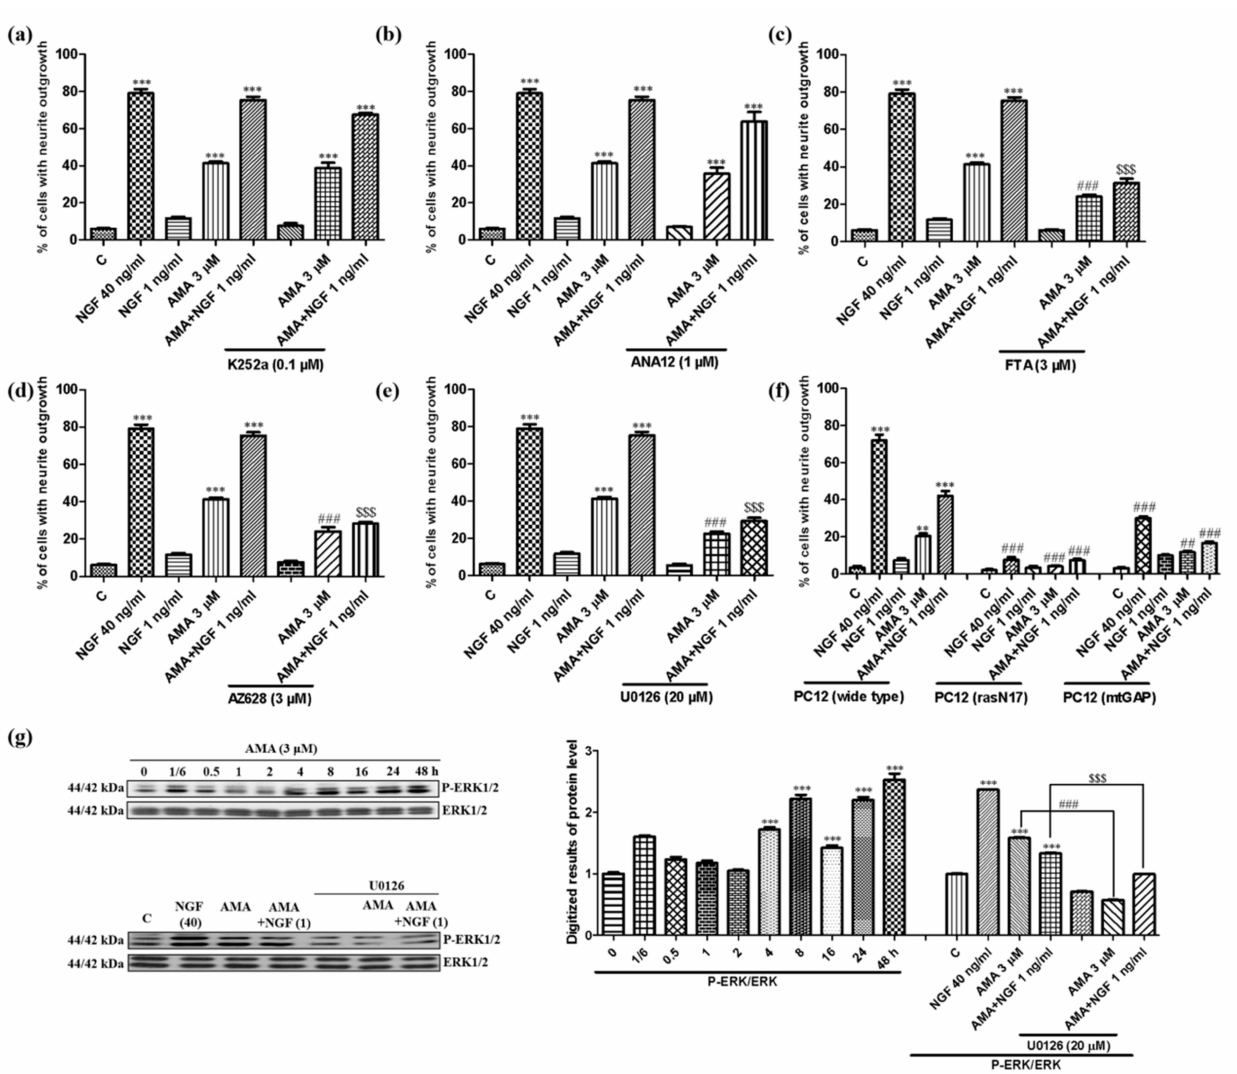
Figure 3. Effect of AMA on the Ras/Raf/MEK/ERK signaling pathway in PC12 cells. ( a , b ) Effect of TrkA inhibitor K252a and TrkB inhibitor ANA-12 on the neurite outgrowth induced by AMA and AMA combined with the NGF. ( c – e ) Effects of Ras, Raf and MEK inhibitors on the neurogenesis activity of AMA and AMA combined with the NGF. ( f ) Percentage of the neurite outgrowth induced by AMA and AMA combined with the NGF for 48 h in wide-type or Ras mutant PC12 cells. ( g ) Phosphorylation of ERK at different time points induced by AMA. The ERK phosphorylation was reduced by the inhibitor of MEK and quantified using Western blots through ImageJ software. Each experiment was repeated three times. ** and *** indicate significant differences at p < 0.01 and p < 0.001 compared with the negative control; ##, ### indicate a significant difference at p < 0.01 and p < 0.001 compared with the 3 µ M AMA group; $$$ indicates a significant difference at p < 0.001 compared with the AMA-combined NGF